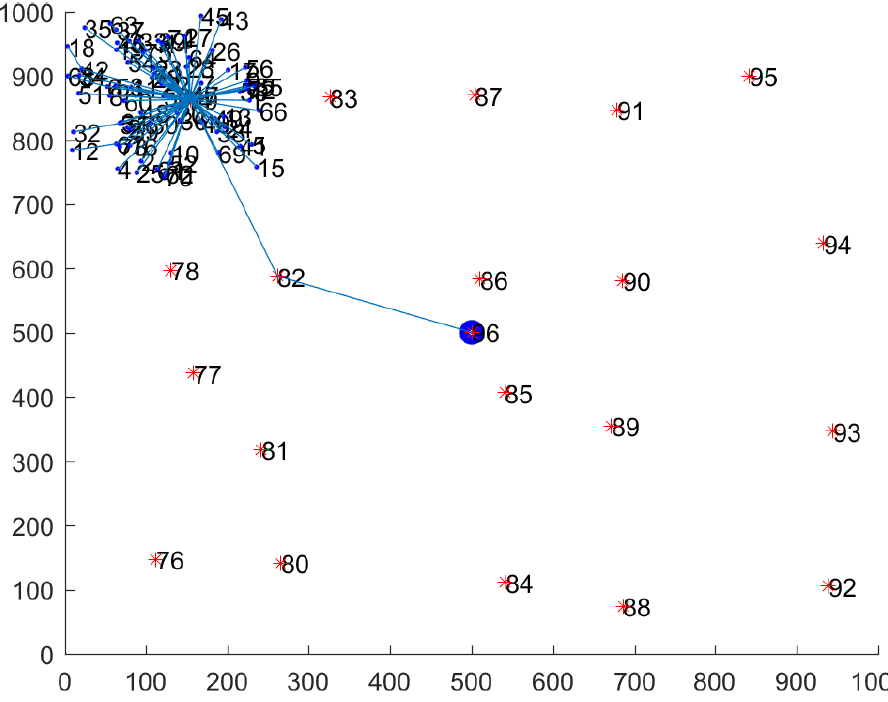
Figure 4. Network routing structure simulation diagram.